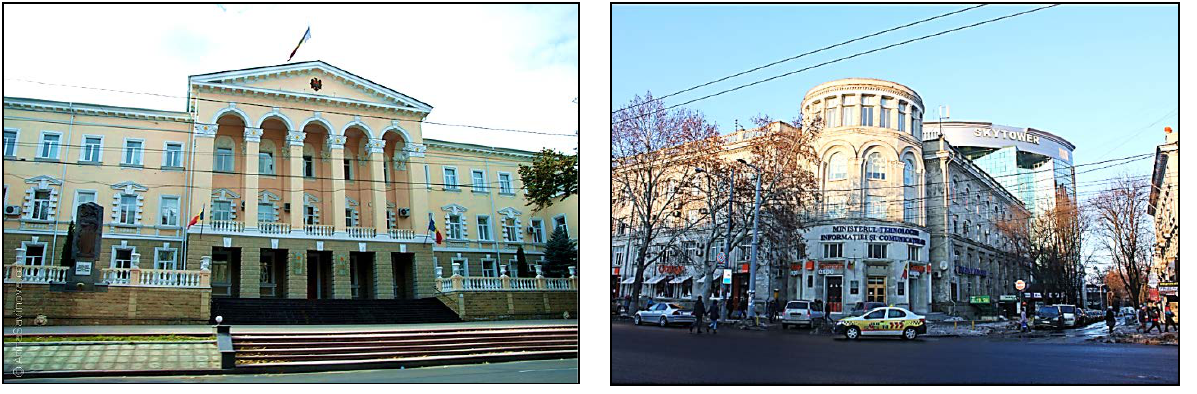
Figure 4. The Ministry of the Interior,1949. Figure 5. The General Post Office